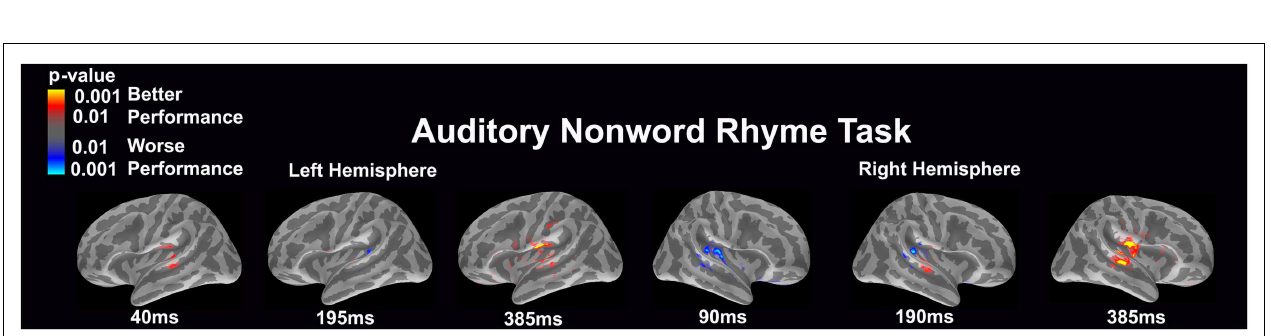
associated with worse performance. Performance was based on the individual participant’s non-word reading ability as indexed by the scaled score on theWoodcock–Johnson IIIWord Attack